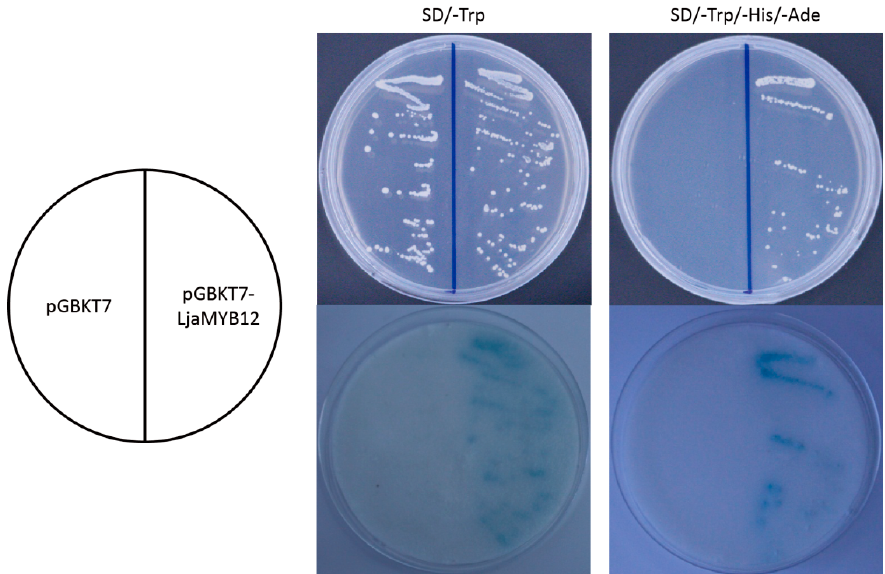
Figure 4. Transactivation assay of the LjaMYB12 in a yeast expression system. The transformed yeast cells were cultured on SD/-Trp or SD/-Trp/-His/-Ade medium plus 3-AT. LacZ activity was assayed using a colony-lift filter assay with β -galactosidase.